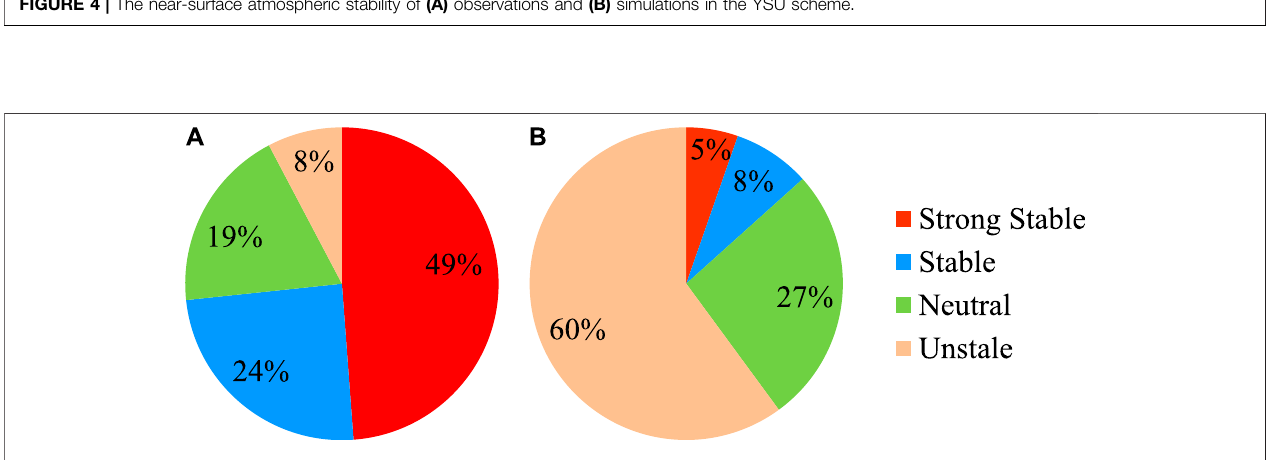
FIGURE 5 | The percentage of near-surface atmospheric stability of (A) observations and (B) simulations in the YSU scheme.